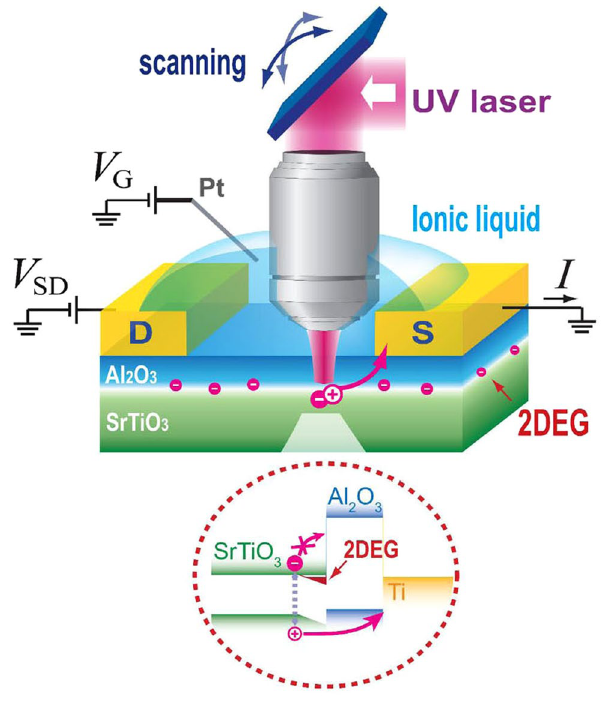
Figure 1. Schematic of SPCM measurement on a 2DEG device. We used a UV (355 nm) laser for the above- band-gap illumination on STO